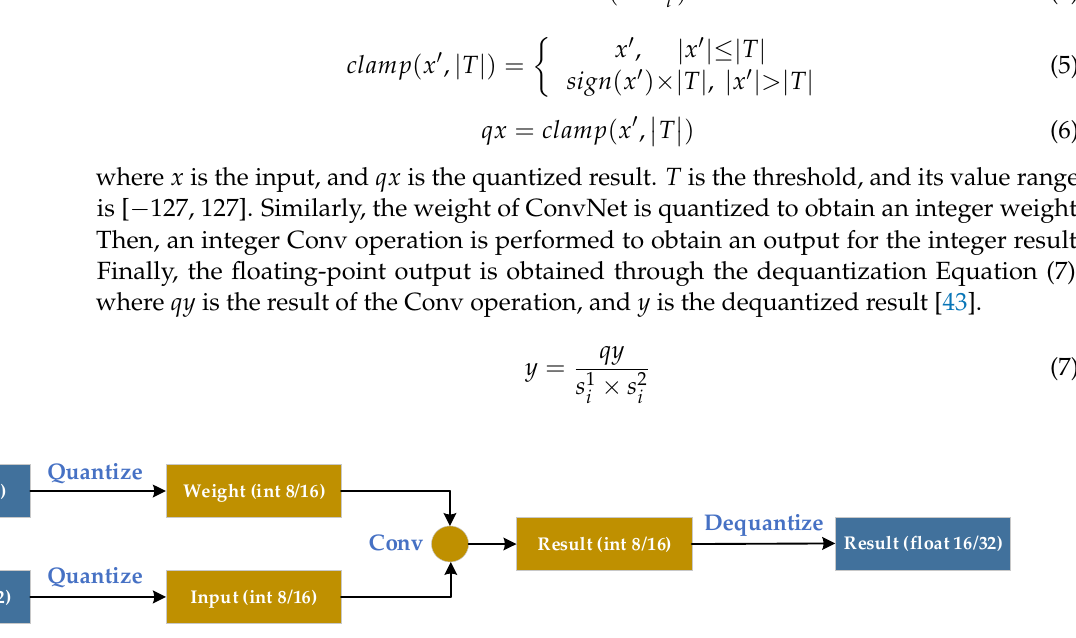
Figure 4. Each network layer’s quantization process.